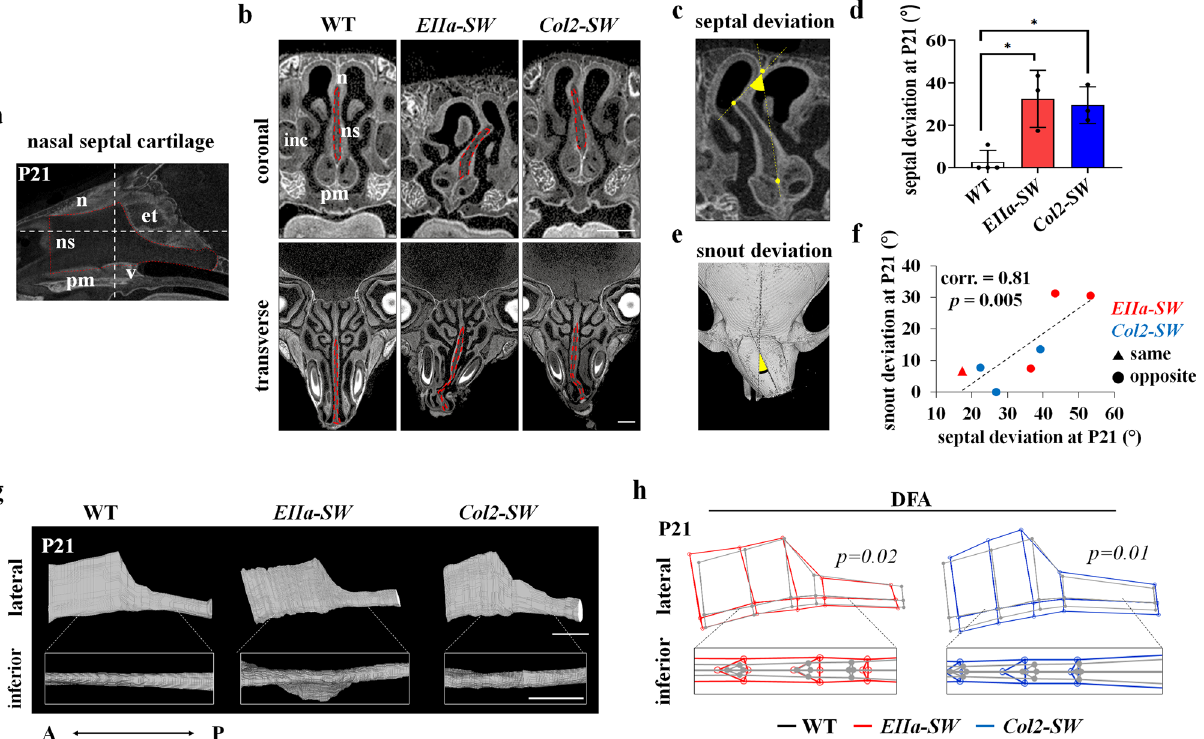
Figure 4. Thickening and deviation of nasal septal cartilage caused crooked snout in mutant mice. ( a ) Midsagittal micro-CT image of the nasal cavity of mice at P21, which were stained with potassium triiodide, the contrast agent (Lugol solution), for 48 h. The dotted red line indicates the nasal septum. The white line indicates the coronal and transverse planes for further analyses. Abbreviations: n, nasal bone; ns, nasal septum; pm, premaxilla; v, vomer; et, the perpendicular plate of the ethmoid bone. ( b ) Coronal view (upper images) and transverse view (lower images) of the nasal cavity. The dotted red line indicates the septal cartilage. Scale bar: 1 mm. ( c , d ) The measurement of septal deviation in the coronal view of the nasal cavity stained with the contrast agent. The measured plane was matched between groups based on the structural features of incisors, premaxilla, eyeballs and vomeronasal organ. The angle of septal deviation between the most deviated point of the septum and the midline (crossing two points on the nasal bone and the caudal most point of the septum) was measured (n ≥ 3). ( e ) Measurement of nasal deviation. The angle between the two dotted black lines, parallel to the interfrontal suture and the nasal bone, was measured (n ≥ 3). ( f ) Correlation between the degree of deviation of the snout and the septum in the mutant mice. The triangle indicates the same deviating direction of the nasal septal cartilage and nose, and the circle indicates the direction opposite of deviation. ( g ) 3D reconstructed images of the nasal septal cartilage at P21 in lateral and inferior views (magnified in the white box). Scale bar: 1 mm. ( h ) Mean septal cartilage shape of EIIa-SW and Col2-SW was compared with that of WT mice by DFA with the wireframe images. The inferior view of wireframe image is displayed in the box ( n ≥ 3). The p values for 1000 permutation tests between two groups are shown with the wireframe images. Values are presented as means ± standard deviations. * p ≤